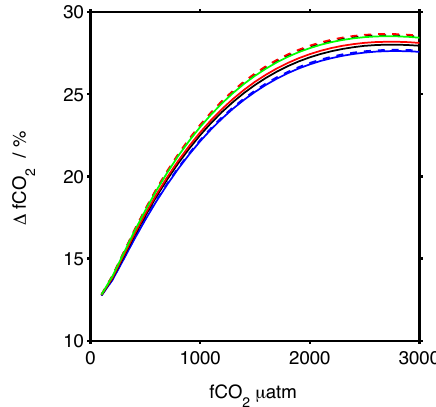
Fig. 7. 1f CO 2 (A as a function of the imposed f CO 2 T ,C T ) and for different choices of the carbonic acid dissociation con- stants as implemented in the standard version of CO2SYS (Roy et al. (1993) (blue, solid), Goyet and Poisson (1989) (blue, dashed), Hansson (1973a, b) refitted by Dickson and Millero (1987) (black, dashed), Mehrbach et al. (1973) refitted by Dickson and Millero (1987) (black, solid), Hansson and Mehrbach data refitted by Dickson and Millero (1987) (red, solid), Millero et al. (2006) (red, dashed), Lueker et al. (2000) (green,